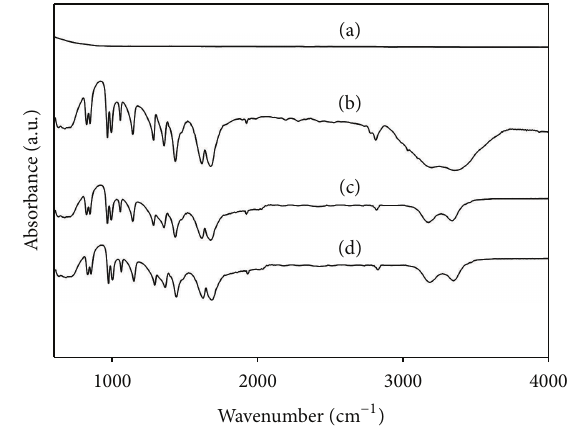
Figure 4: FT-IR spectra of (a) TiO 2 NTs, (b) pure acrylamide, (c) MIP-TiO 2 NTs, and (d) NIP-TiO 2 NTs.